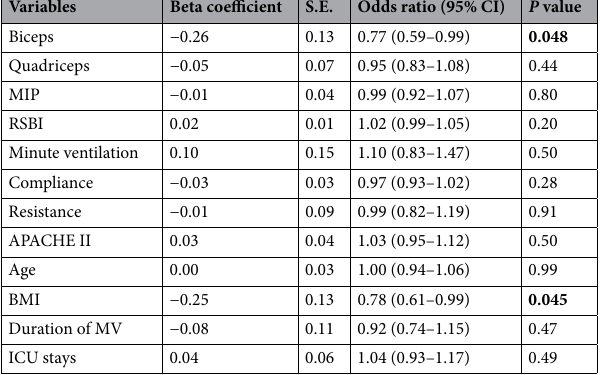
Table 5. Univariate logistic regression analysis of In-hospital mortality. Bold values are statistically